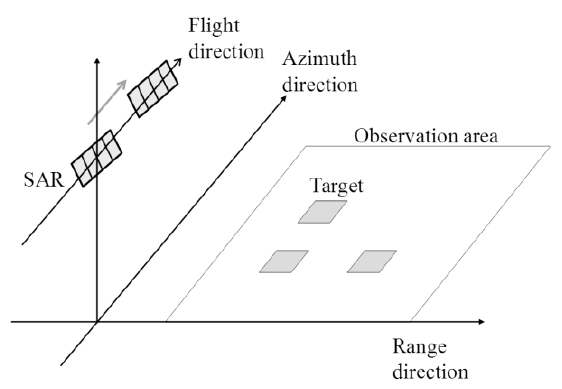
Figure 3. Schematic image of stationary